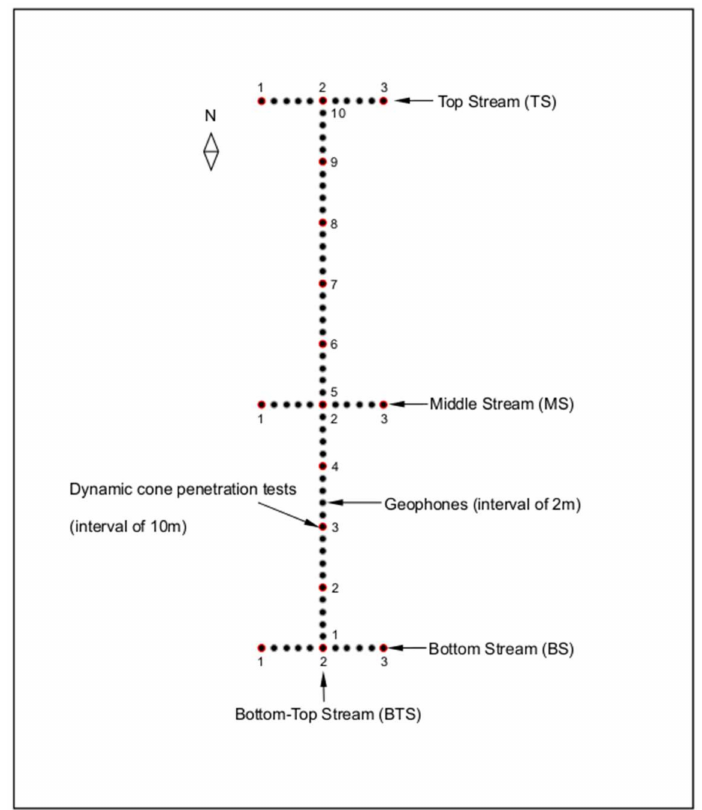
Figure 3. Locations of the field investigations, including seismic survey and dynamic cone penetrometer (DCP). Note: the numbers with red circles denote the DCP testing sites (BS: 3 holes, MS: 3 holes, TS: 3 holes, and BTS: 10 holes); and the distance between each number in the figure is 10